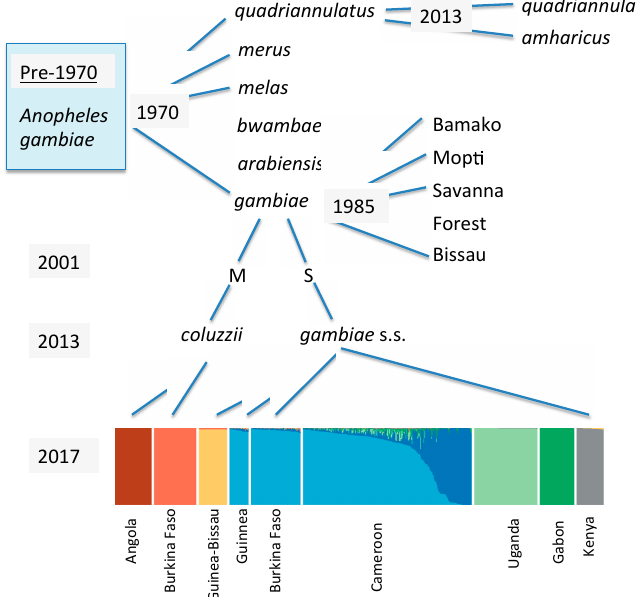
Figure 1. Schematic history of the taxonomy and genetic diversity of Anopheles gambiae . The light blue box in upper left indicates it was considered a single species up to the 1960s. Italicized names are formally described species; non-italicized designations are informal “forms”. The bottom colored block is a STRUCTURE plot [10] based on whole genome sequencing. Summarized from work reported in [11–15].